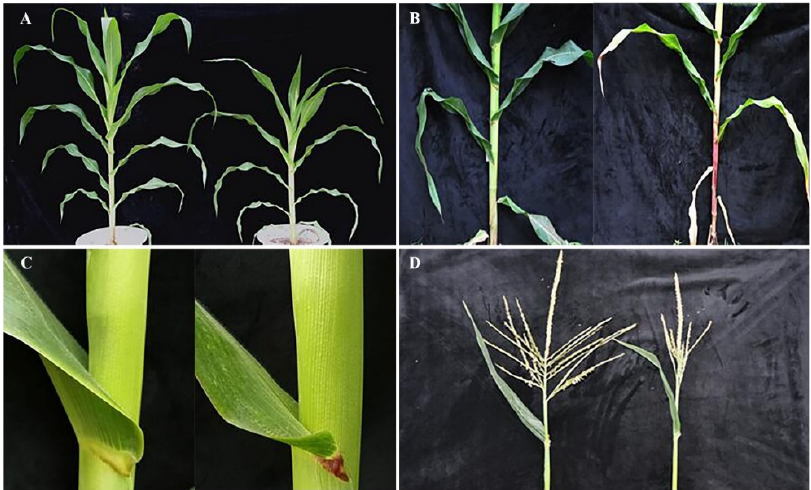
Figure 2. Phenotypic analysis of wild-type and mutant lpa1 . ( A ) Plants at trumpet stage; ( B ) main stem at male drawing stage; ( C ) corresponding leaf angle in A; ( D ) male spike: the left side is wild type and the right side is mutant.